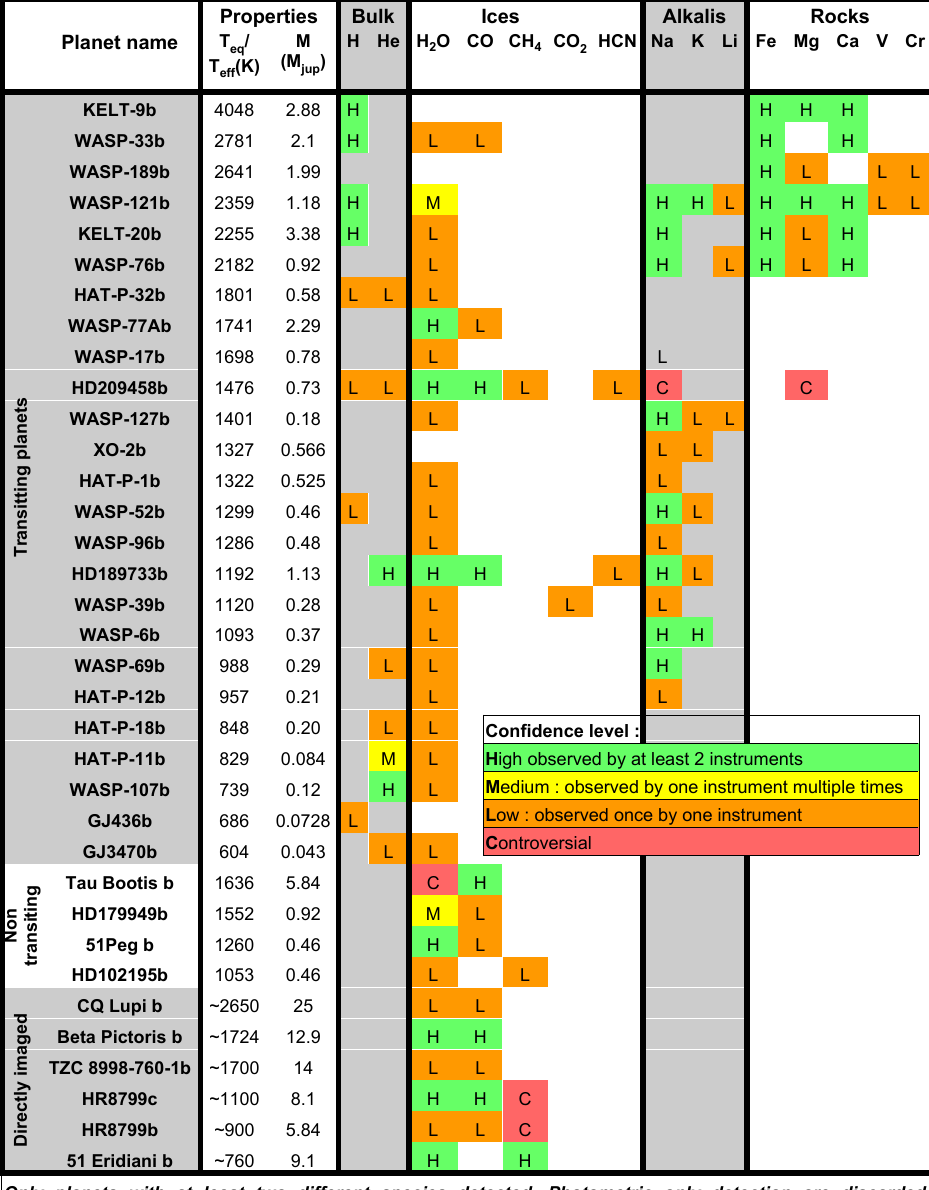
Figure 3. Chemical species detected in exoplanet atmospheres as of October 2022. Confidence level of the detection is shown in color. Few species have been strongly detected so far. The bottom right corner of this table is empty, which may be linked to condensation of the species. Figure adapted from Guillot et al. [27], where the citations for the detection are regrouped in its appendix. We added CO 2 detection on WASP-39b [6] and H detection on GJ436b